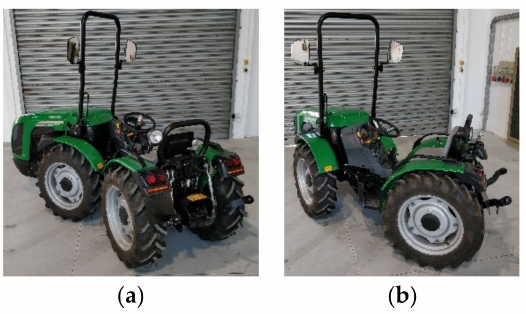
Figure 2. Articulated tractor: ( a ) articulation to the left; ( b ) articulation to the